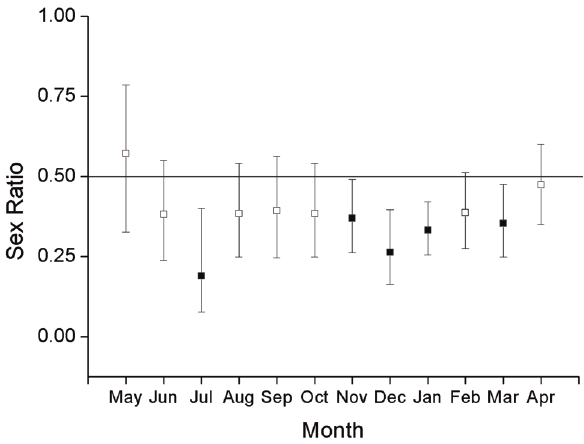
Figure 5. Sex ratio (estimate ± SD) by month of Panopeus austrobesus in the mussel farm at Itaguá Beach, Ubatuba, State of São Paulo, Brazil. Black squares indicate a deviation from a 1:1 sex ratio.